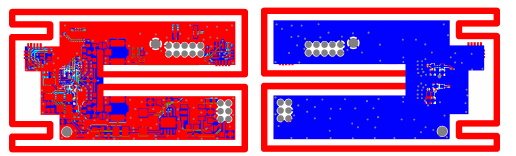
Figure 3. SPW-1: Top copper layer (left) and bottom copper layer (right) of the circuit board. The differentially-fed loop antenna is printed around the other